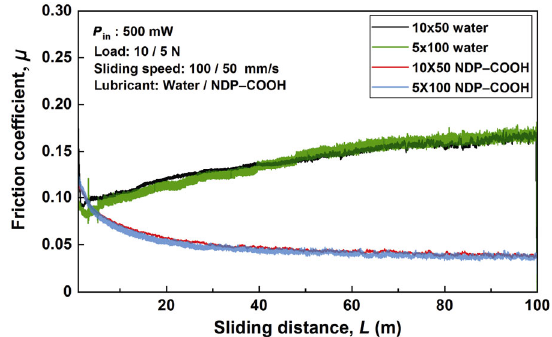
Fig. 14 Friction evolutions in water and NDP–COOH at P = 500 mW combined at 10 N × 50 mm/s and 5 N × in 100 mm/s. Friction coefficients in NDP–COOH are plotted as average curves fitted from those at three concentrations